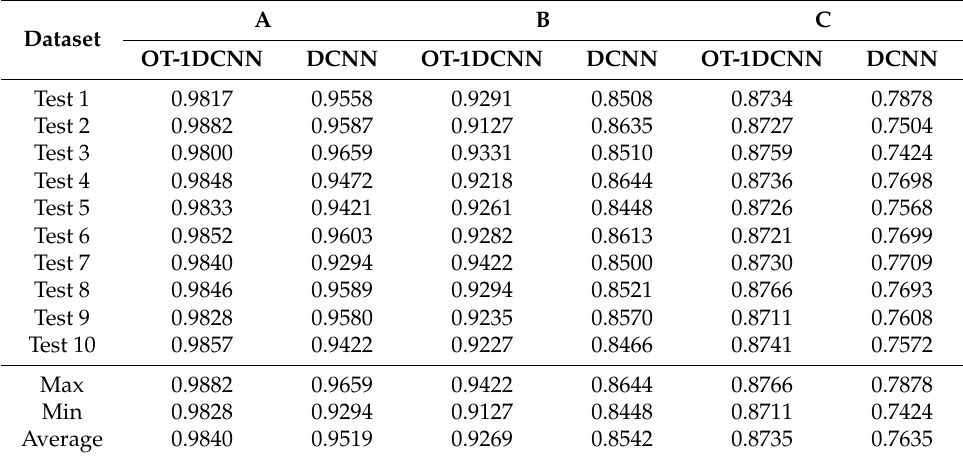
Figure 13. Diagnosis results of each dataset from self-made device: ( a ) diagnosis results of dataset A (the former is OT-1DCNN, the latter is DCNN); ( b ) diagnosis results of dataset B (the former is OT-1DCNN, the latter is DCNN); ( c ) diagnosis results of dataset C (the former is OT-1DCNN, the latter is DCNN). Table 7. Diagnosis results of each dataset from the self-made